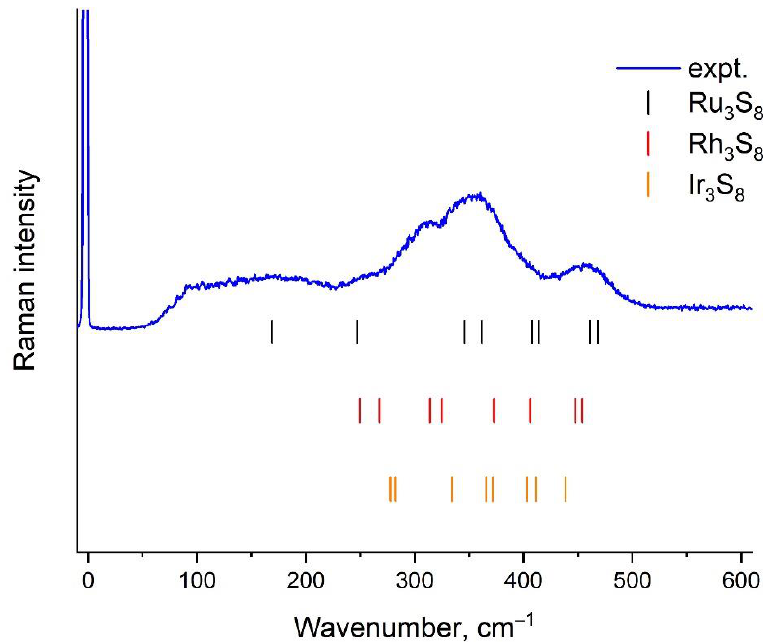
Figure 10. Experimental (blue spectrum) Raman spectrum of the sample (Rh,Ir,Ru) 3 S 8 and calculated dashed spectral diagrams of Ru 3 S 8 (black), Rh 3 S 8 (red), and Ir 3 S 8 (orange).